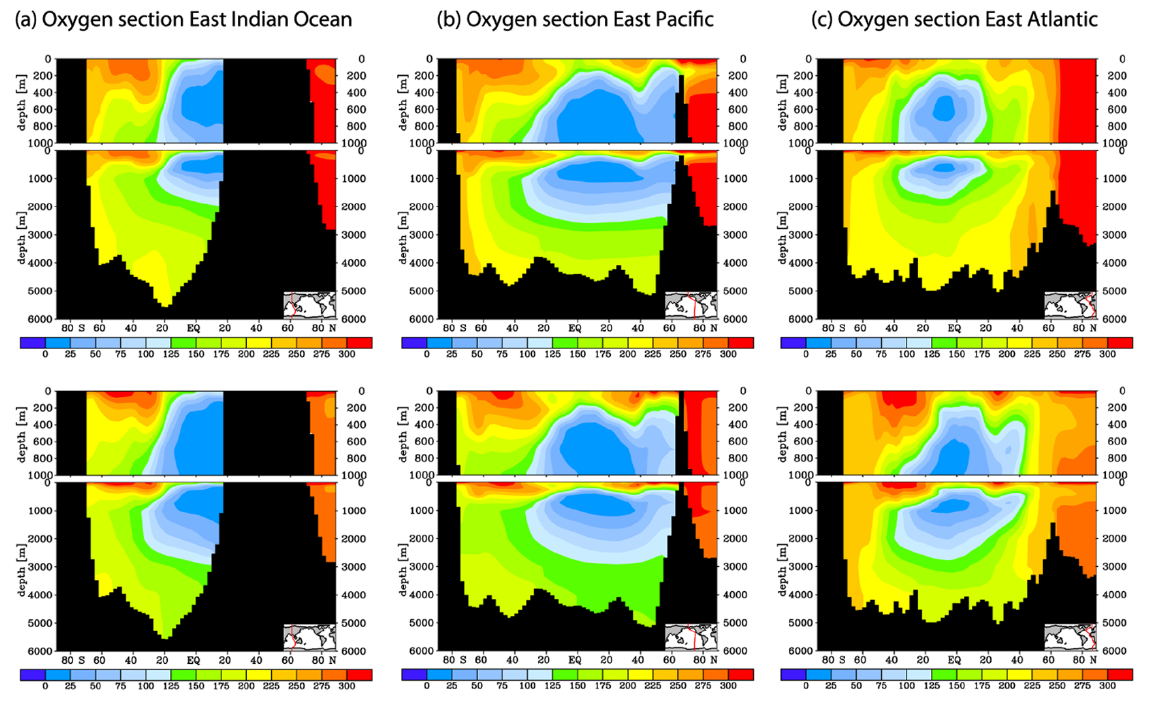
Fig. 9. Oxygen meridional sections in the (a) east Indian Ocean, (b) east Pacific and (c) east Atlantic in the model reference run (top line) and the LGM simulation with shelf input (bottom line). Units in µmoll − 1 .